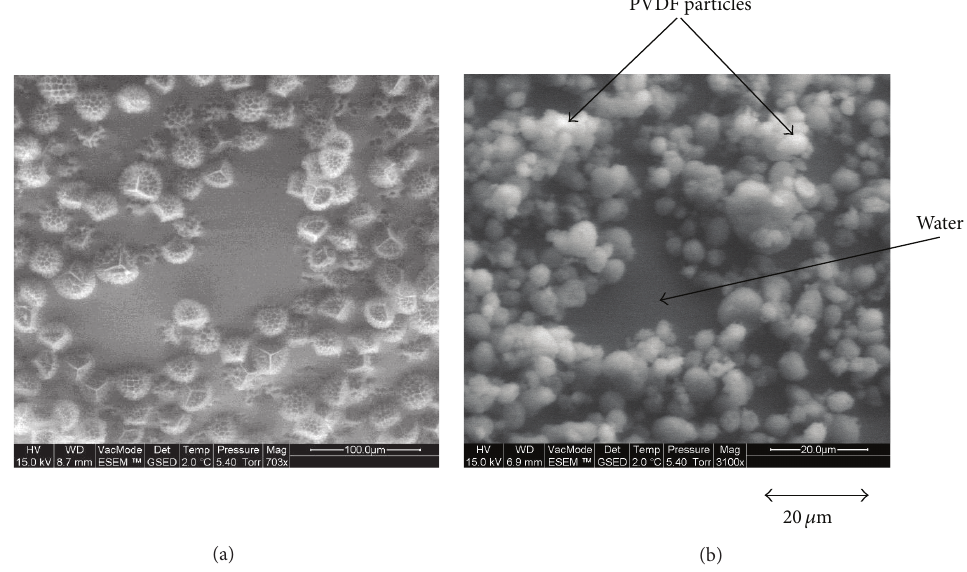
Figure 3: (a) ESEM image of the surface of liquid marble coated with lycopodium particles. Scale bar is 100 𝜇 m. (b) ESEM image of the marble’s surface (white spots are aggregates comprising particles of PVDF). Scale bar is 20 𝜇